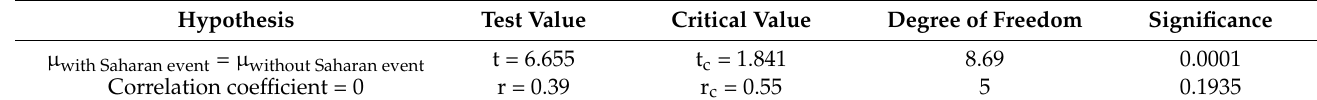
Table 2. t -test about two means and correlation test.